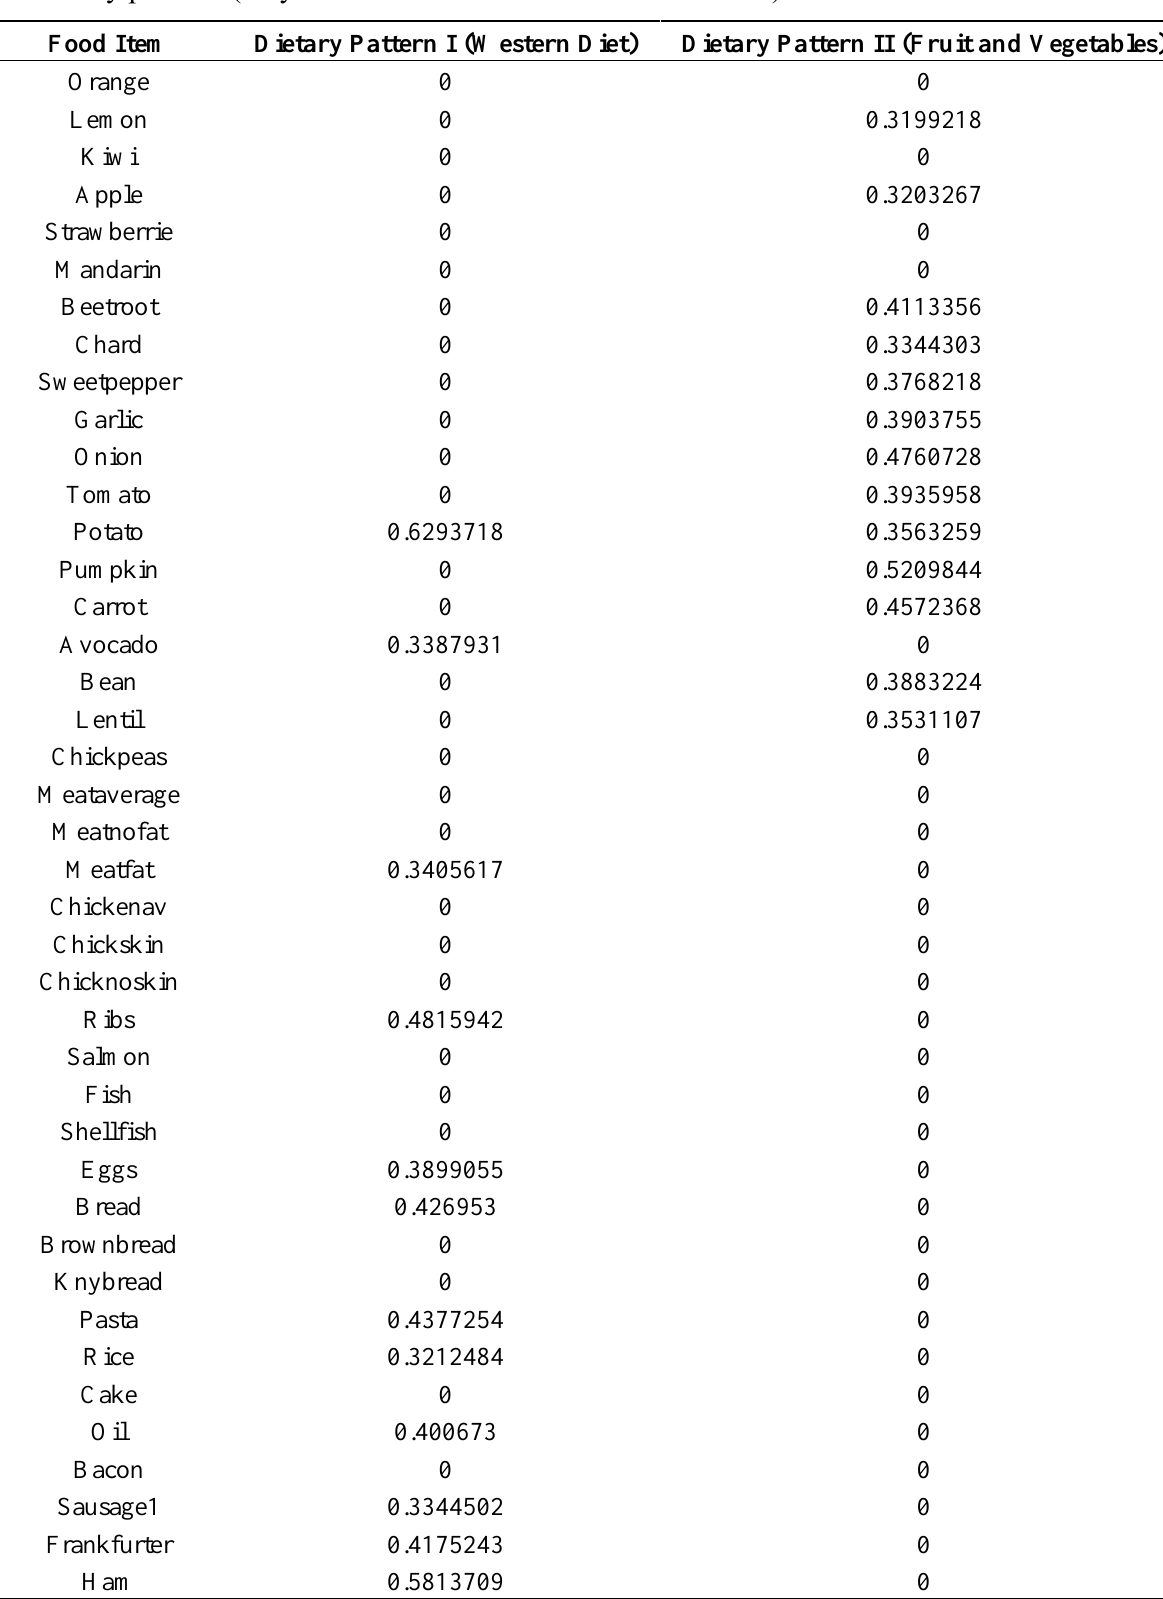
Table A1. Empirically Derived Dietary Patterns. Correlations between food items and dietary patterns (only correlations >0.3 or <−0.3 are